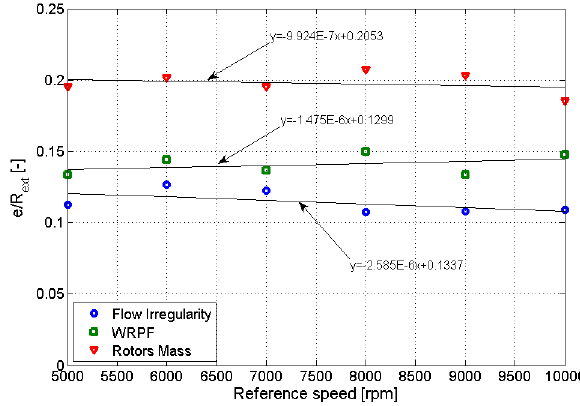
Figure 16. e / R ext ratios for the optimized Figure 16. 𝑒 𝑅 (cid:3032)(cid:3051)(cid:3047) ⁄ ratios for the optimized gerotors .